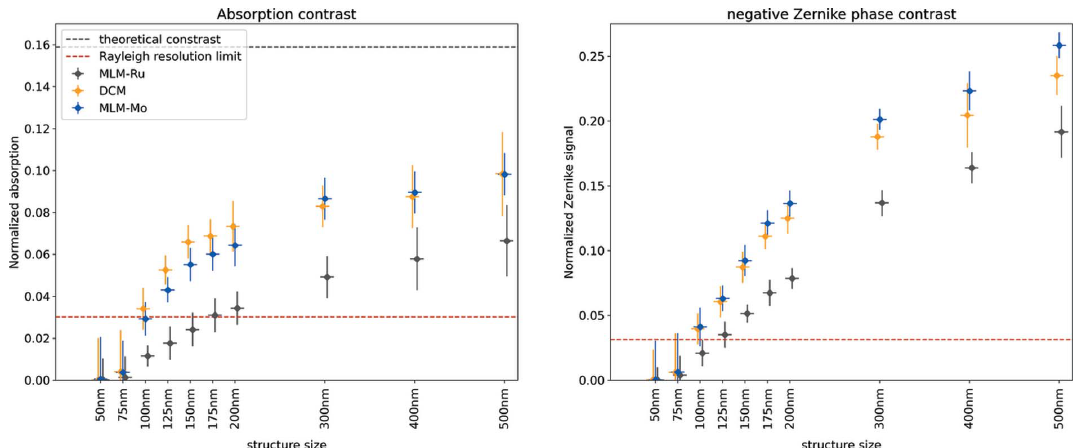
Figure 8 Contrast levels between line and space structures in the Siemens star for different structure sizes. The Rayleigh resolution limit, as defined by the X-ray optics, is plotted as well. For absorption (left), we have also given the theoretical contrast level (16% absorption). The data points for the Si-111 DCM are shifted very slightly to the left and the data points for the Ru/B 4 C MLM slightly to the right to improve the visualization, but the analysis has been performed for the same structure sizes. The legend applies to both subplots.